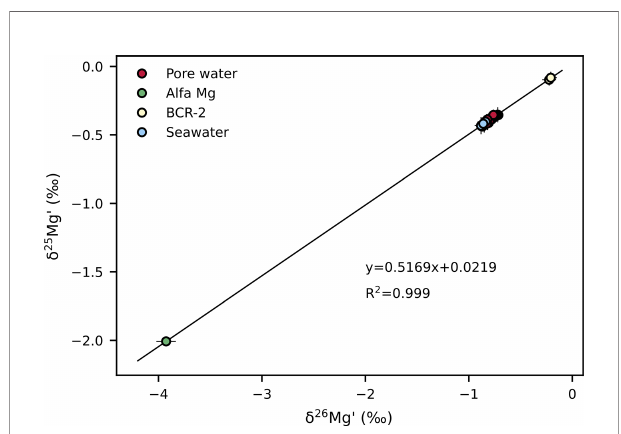
FIGURE 4 | Plot of d 25 Mg ’ vs. d 26 Mg ’ illustrating Mg isotopic composition of pore water and standards (Alfa Mg, BCR-2, seawater). Solid line represents the regression line of all data.